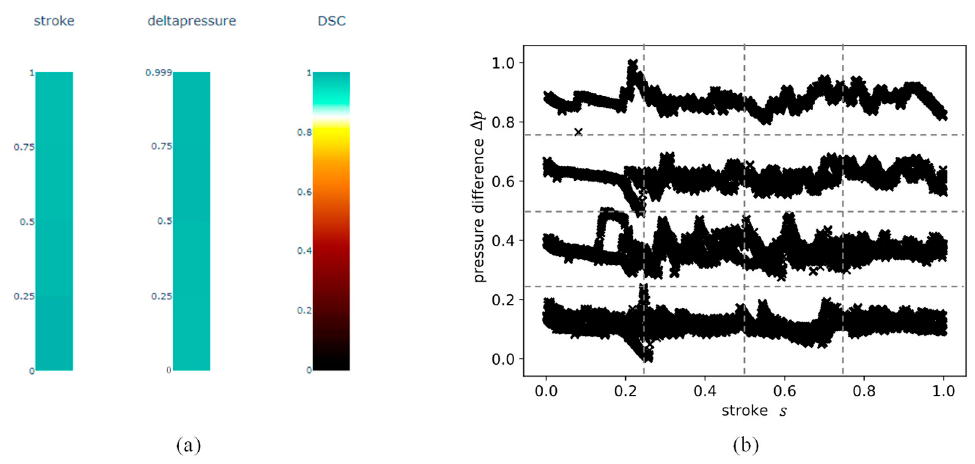
Figure 11. ( a ) Screenshot of the visualization of data set completeness for stroke s and pressure difference ∆ p and ( b ) two-dimensional scatter plot of stroke s and pressure difference ∆ p .